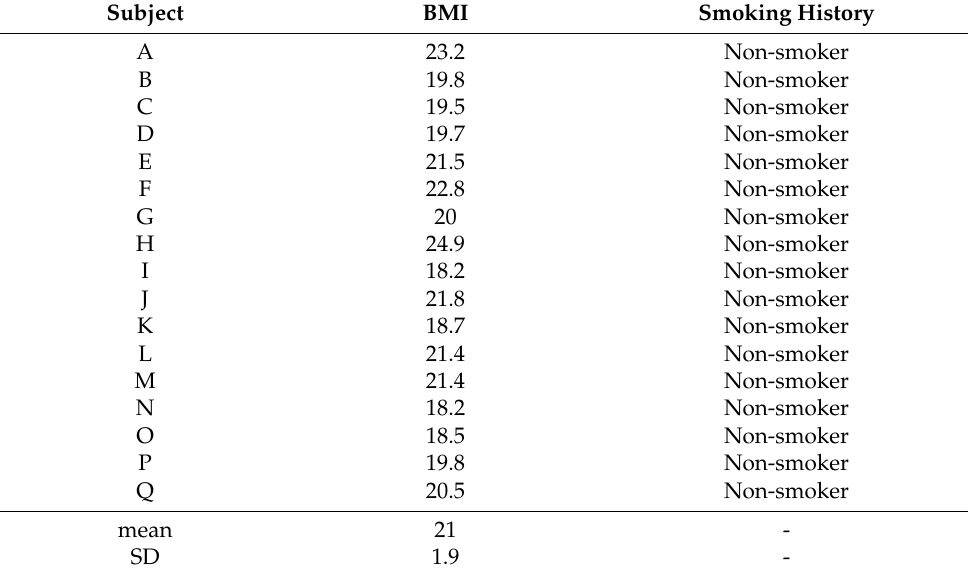
Table 1. BMI and smoking history of the